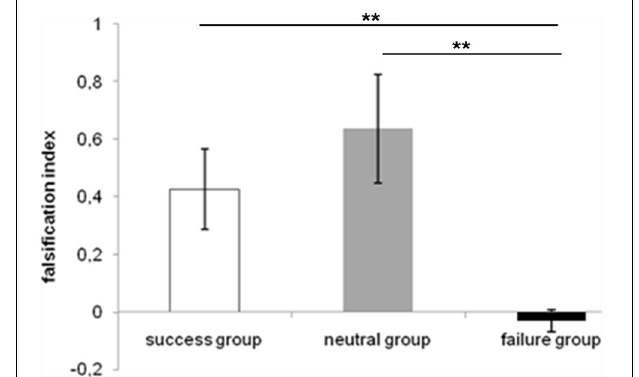
each group. It represents the choices of p and not-q in order to falsify the rule (modus tollens). ∗∗ p ≤ 0 . 01.